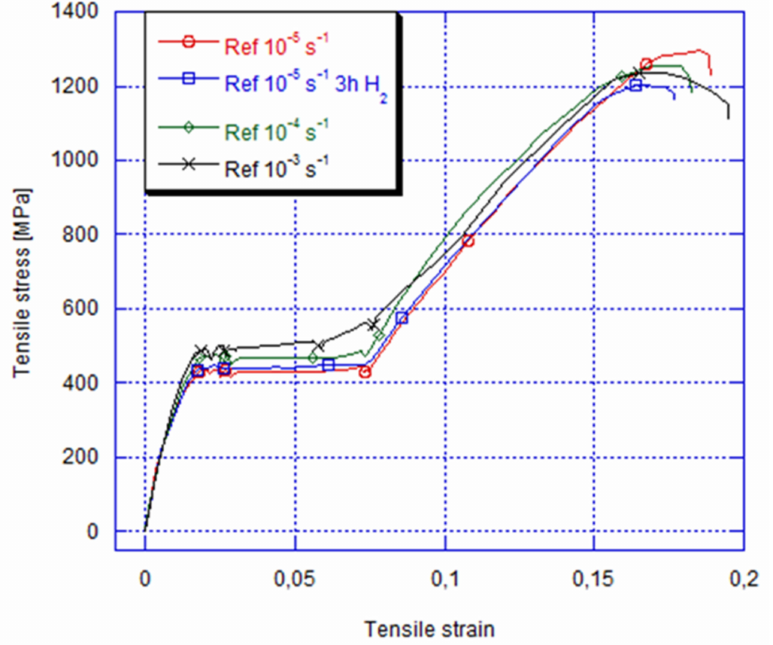
Figure 3. Typical engineering stress–strain curves of superelastic Ni-Ti alloy immersed for 3 h and aged for 24 h at different strain rates of 10 − 5 s − 1 , 10 − 4 s − 1 and 10 − 5 s − 1 and as-received at 10 − 5 s − 1